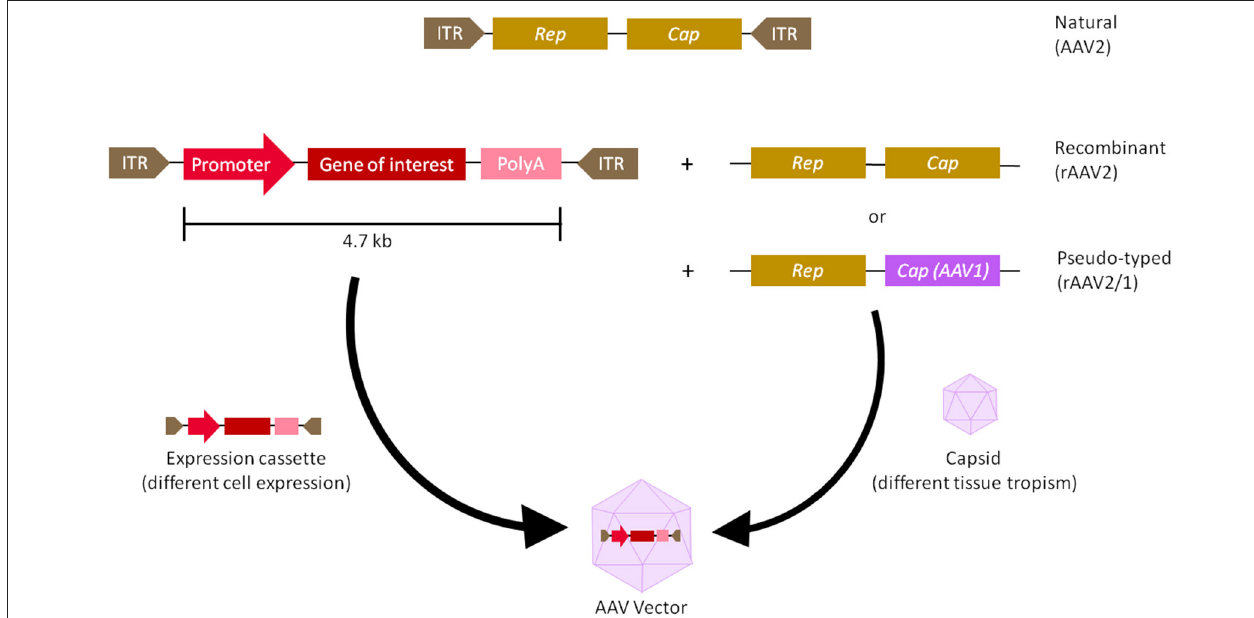
FIGURE 1 | Adeno-associated virus (AAV) vector biology. The natural AAV serotype contains three open reading frames flanked by two inverted terminal repeats (ITR)— Cap (capsid) and Rep (replication). In recombinant AAVs (rAAV), the viral genome is replaced by a synthetic expression cassette containing a promoter, transgene of interest and a terminator such as polyadenylation (polyA) sequence, flanked by the ITRs. Cap and rep sequences are supplied as a plasmid in trans , which will produce the viral capsid that packages the expression cassette. To create a pseudo-typed vector (e.g., AAV2/1), the cap genes from another AAV serotype (e.g., AAV1) can be used to package the recombinant genome of another serotype (e.g., AAV2). rAAVs can be customised at the capsid and promoter level. The capsid gives AAV its tissue tropism, meaning the cells it infects, while the promoter drives either ubiquitous or tissue-specific expression of the